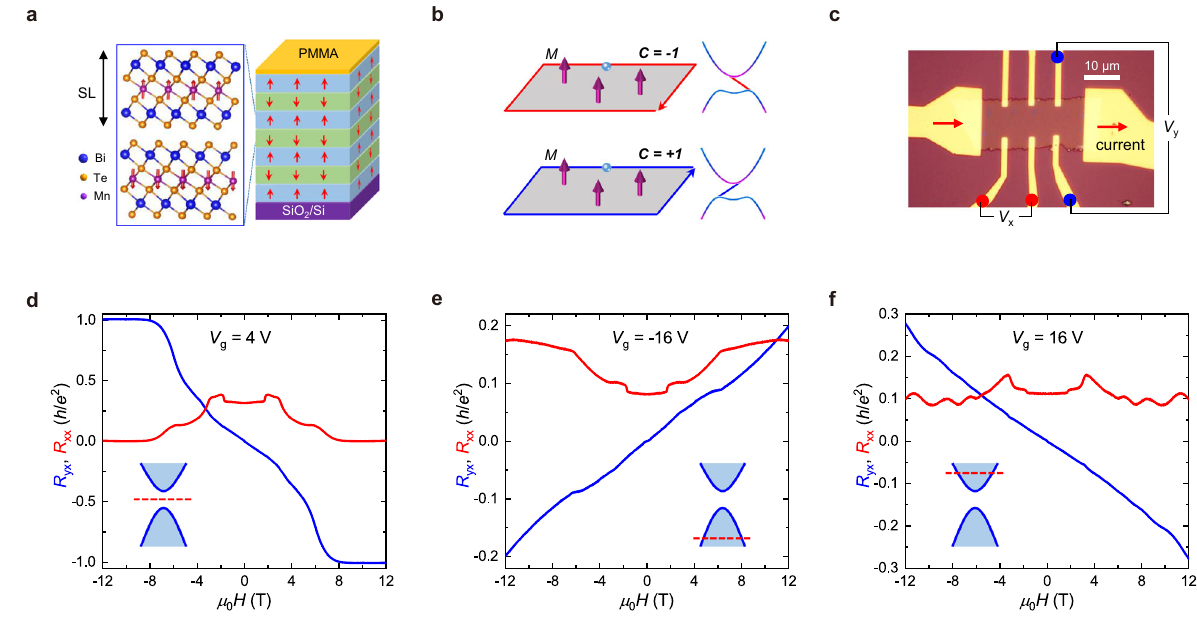
Fig. 1 Basic properties of a 7-SL MnBi 2 Te 4 . a Schematic crystal and magnetic structures of the 7-SL MnBi 2 Te 4 device. b Con fi gurations of chiral edge state in the Chern insulator with Chern number C = − 1 and + 1. The opposite chirality of the edge state is marked by red and blue lines with arrows. The magenta arrows denote the magnetic moments. The schematic electronic structures for the two cases are shown on the right, with the opposite slope of the linear band representing opposite chirality. c Optical image of Device #7-SL-1 and the measurement setup. d Magnetic fi eld dependent R xx (red) and R yx (blue) at V g = 4 V and T = 2 K. The Chern insulator phase is realized when the magnetic fi eld is above 8 T, which is characterized by the R yx = − h / e 2 plateau and R xx = 0. e As V g is tuned to − 16 V, the transport is dominated by hole-type carriers. The jumps in R xx at a magnetic fi eld of around 1.8 T, 4 T, and 7 T correspond to the successive fl ips of Mn 2 + moments in different SLs. f At V g = 16 V, the E F is tuned to the conduction band and the transport exhibits characteristic features of the 2D electron gas. The insets in d to f roughly show the position of E F at according V g